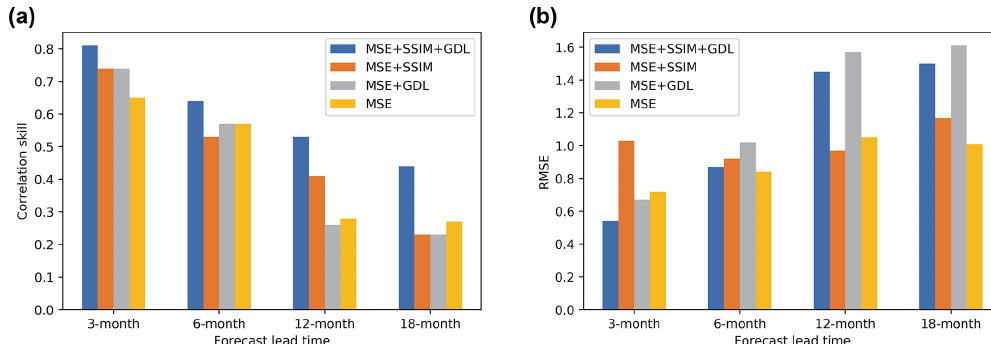
Figure 5. The performances of the ENSO-MC with different loss functions.